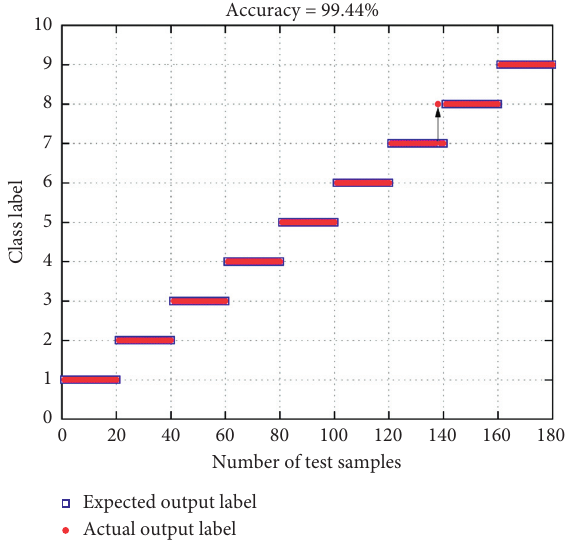
Figure 13: Classification result of the proposed model.